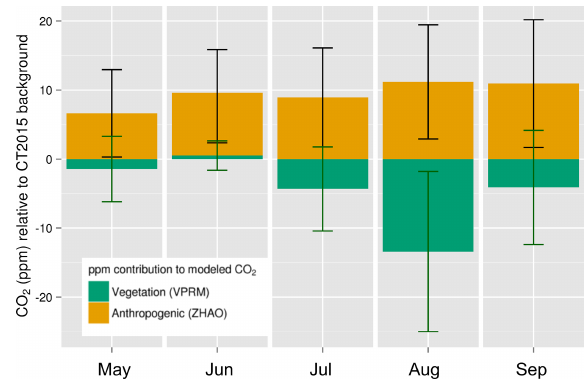
Figure 5. Modeled mean monthly contribution (ppm) to Miyun CO2 concentrations from vegetation (VPRM) and anthropogenic (ZHAO) sources. Enhancement and depletion are relative to ad- vected CT2015 background concentrations during the regional growing season (MJJAS), averaged over 2005 to 2009. Vertical lines represent 1 σ of monthly averages (green: vegetation; black: anthro- pogenic). Negative values represent depletion from CT2015 back- ground; positive values represent enhancement of CT2015 back-